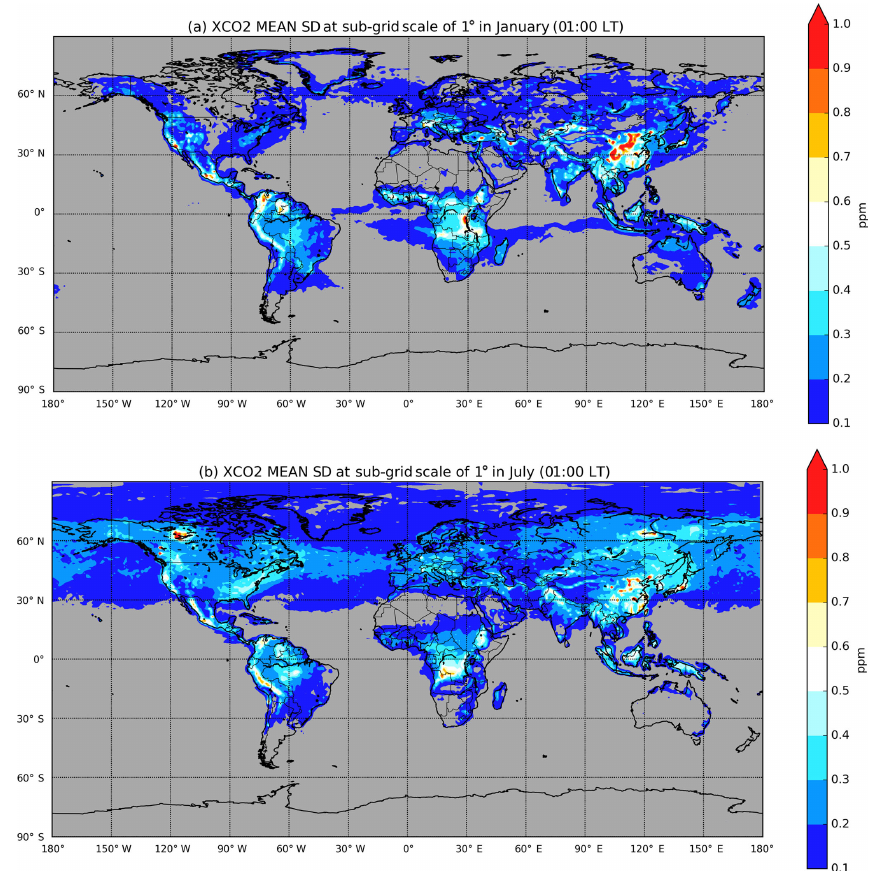
Figure 14. Monthly mean XCO 2 small-scale variability ( σ ) within 1 ◦ × 1 ◦ grid boxes (ppm) at 01:00 local time in (a) January and (b) July. Grey shading denotes σ < 0 .